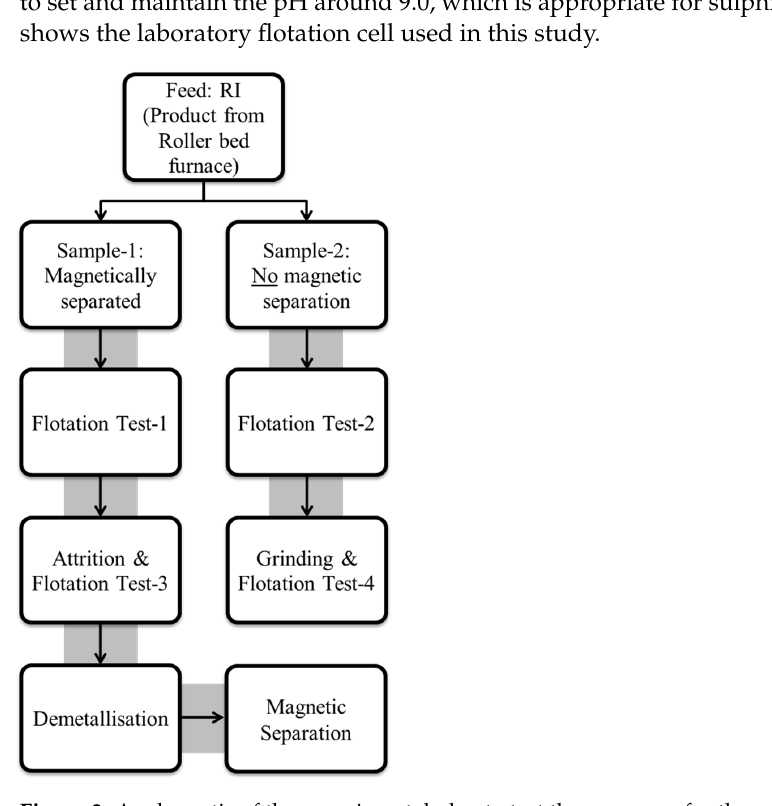
Figure 3. A schematic of the experimental plan to test the processes for the separation of sulphidised chrome spinels from RI (reduced ilmenite).